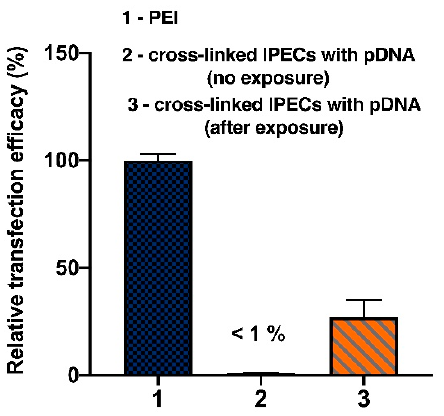
Figure 12. Transfection of HCE-T cells with pCMVL by IPECs ([Lys–NH 3+ ]:[pDNA–PO 4 − ]:[Hep– SO 3 − ]:[linker] = 1:0.5:4:0.8). Mean ( ± SD), n =